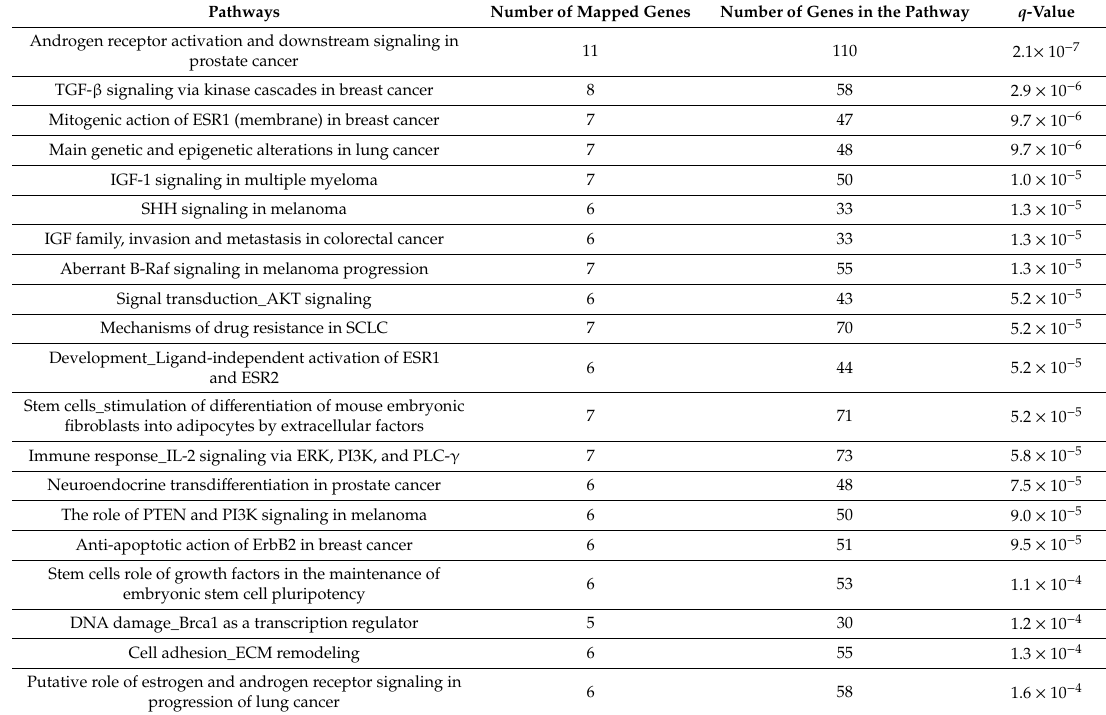
Table 4. Pathway enrichment analysis using possible target genes of the miRNA whose plasma levels showed negative correlations with CHA 2 DS 2 -VASc